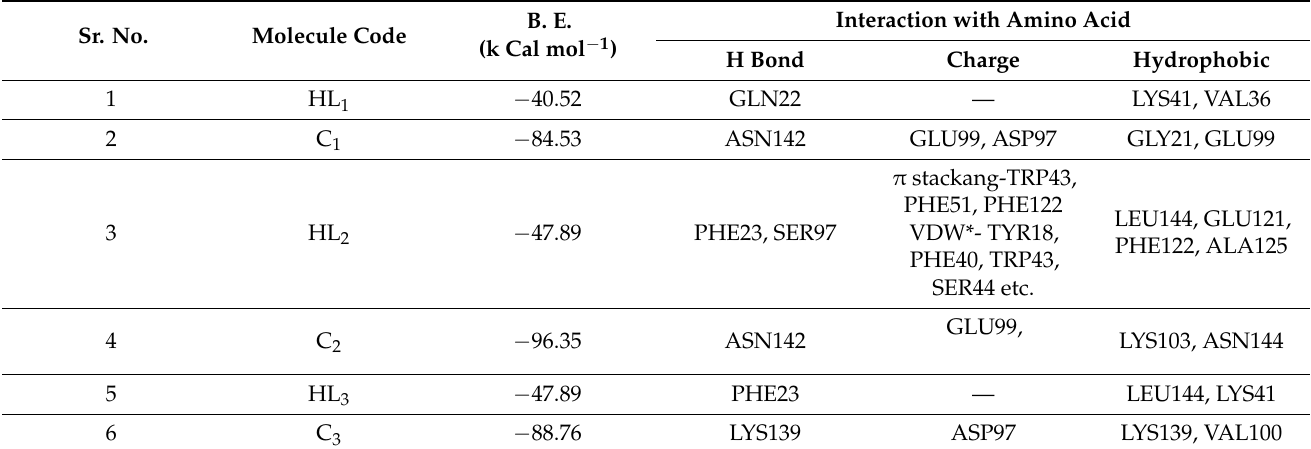
Table 9. Binding Interaction of Schiff bases and their Ni(II)